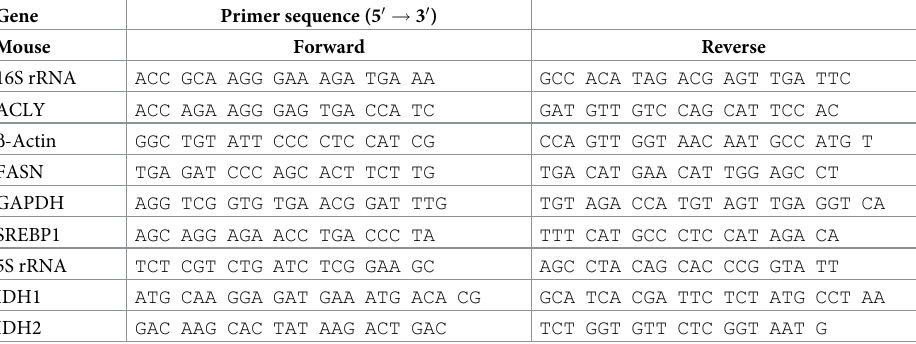
Table 1. Primers used in qPCR analysis for gene candidates of